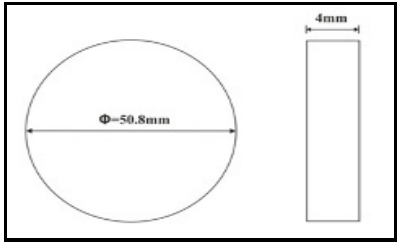
Fig. 9. Schematic Specimen for Standard Specimen of Hardness Test.